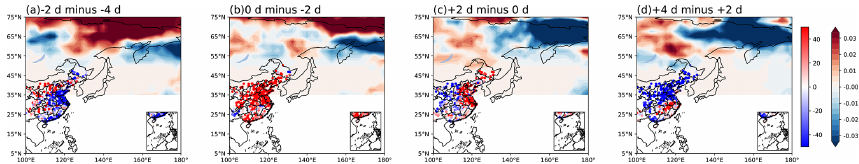
Figure 10. Composite anomalies of (a–d) the spatial distribution of PM 2 . 5 concentration variations (unit: µgm − 3 ) and blocking from − 4 to 4d related to Type3 severe HD EC occurrences.